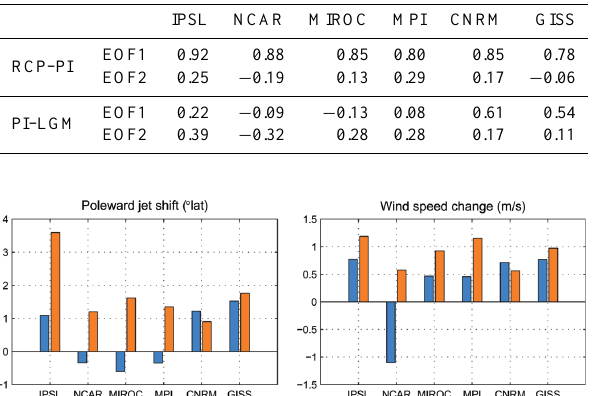
Table 1. Spatial (90–0 ◦ latitude) correlation of anomaly patterns of 850-hPa zonal-mean zonal wind: the first and second EOFs of the PI simulation, and the PI–LGM and RCP–PI differences.